Question: What style of plot is this figure drawn as?
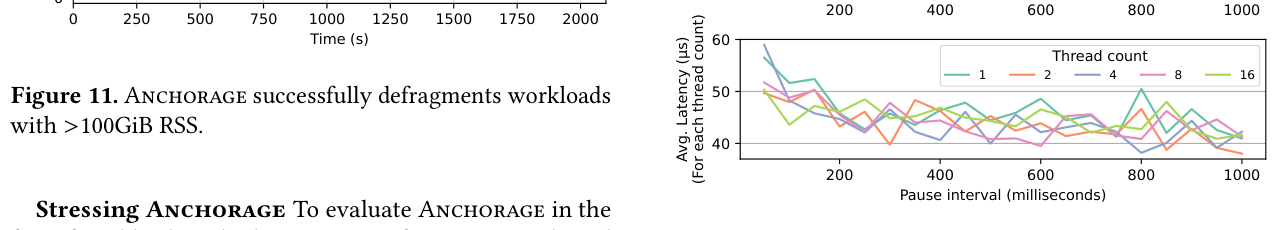
Answer: line